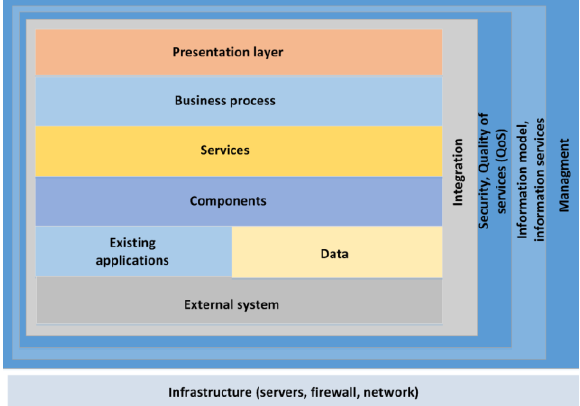
Figure 1. Service-oriented architecture On the figure above, layers: „Integration”, “Security, Quality of Services (QoS)”, “Information Model, Information Services” and “Management” are displayed vertically. The reason for this is that the functionality provided by these 4 layers is used by all other